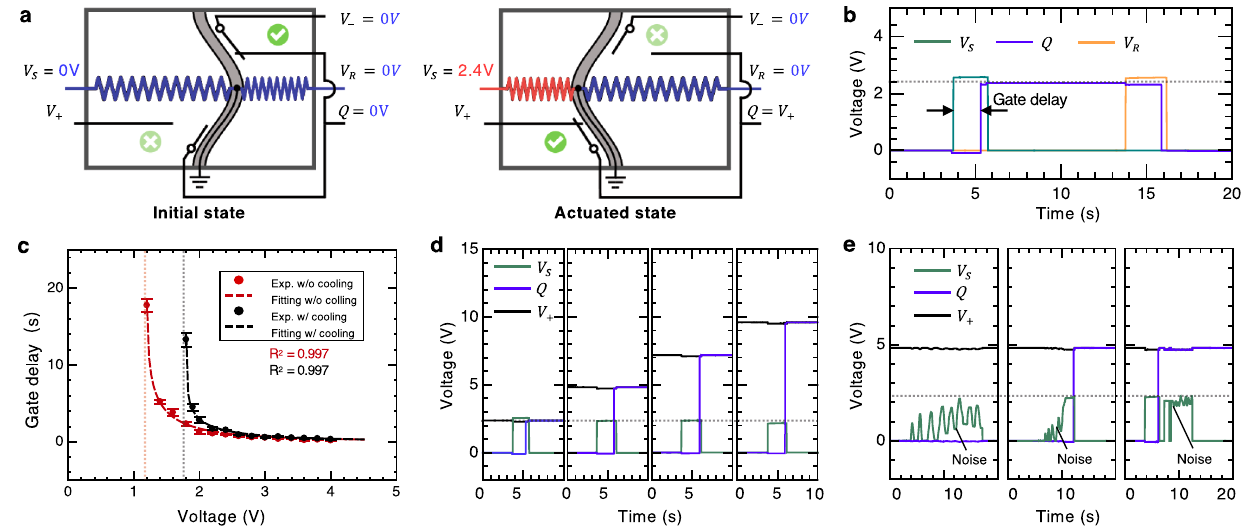
Fig.2|CharacterizationofOMS.a TwostatesoftheOMSwithlabelsoftwoinputs, V − ,twocontrolsignals( V S and V R ),andoneoutput, Q . b Typicaloperationof V + and the OMS with V S =2.4V, showing a gate delay of ~1.5s. Before the next cycle of operation, a voltage, V R is applied to switch the bistable beam back to reset the OMS. c Gate delay of OMS as a function of selection voltage, V S , with/without